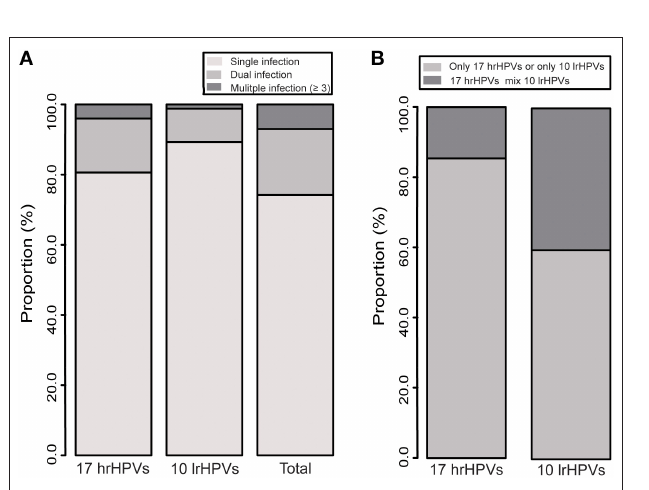
two-fold elevated for HPV 59 (4.3), 51 (3.8), 11 (3.5), 66 (3.4), 39 (3.2), 35 (3.0), 18 (2.8), 33 (2.7), 56 (2.5), 45 (2.4), 16 (2.3), and 52 (2.1). Additionally, the co-infection of HPV 11 with one